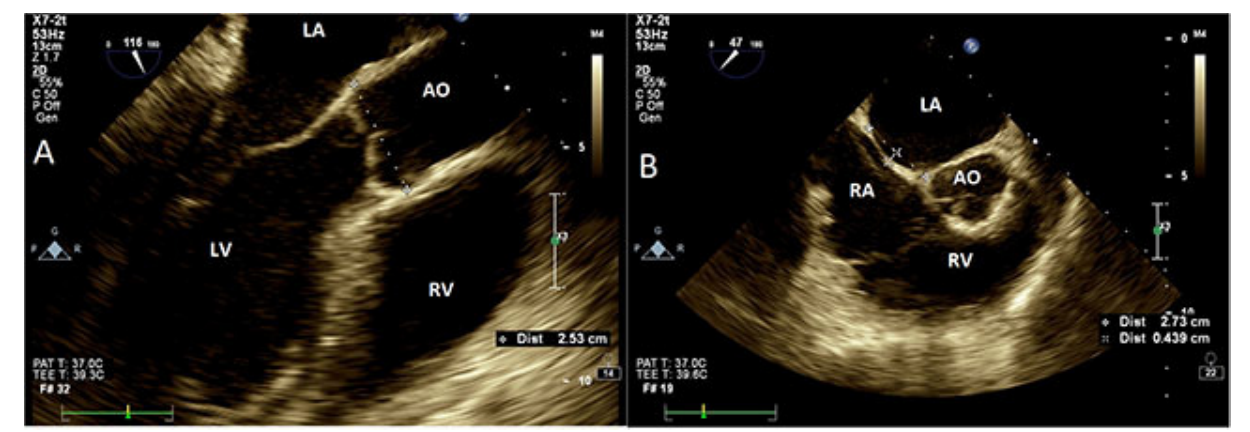
FIGURE 1 | Transesophageal echocardiography. (A) Aortic measurements at Valsalva sinus plane (120 ◦ , mid-esophageal view). Aorta measured at leading edge echo signal of posterior wall to the leading edge of anterior wall. (B) Interatrial septal size and oscillation (25–45 ◦ , mid-esophageal view) measured as the maximal perpendicular distance from an imaginary line drawn between atrial septal insertion points (dashed line). AO, aorta; LA, left atrium; RA, right atrium; LV, left ventricle; RV, right